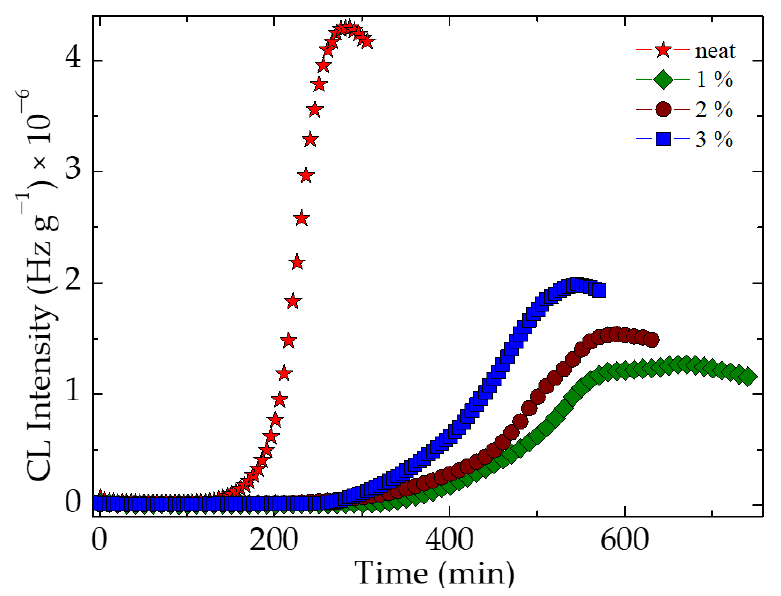
Figure 6. Isothermal CL spectra recorded on the samples of SIS containing different graphene loadings; measurement temperature: 130 °C.